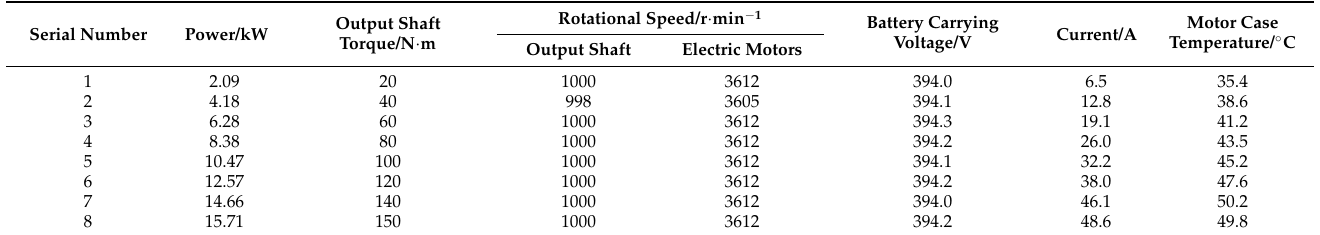
Table 7. Experimental results of PTO motor power in rotary tillage